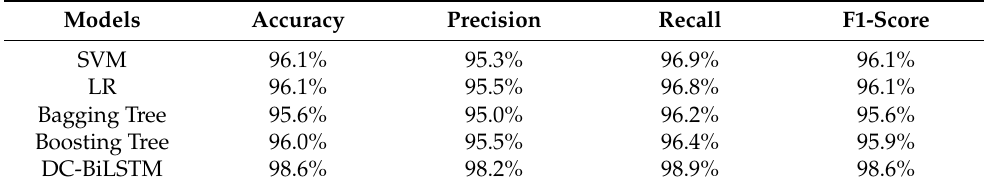
Table 4. Comparative analysis of the performance of multiple classifiers in distinguishing between benign and malignant tissue. The performance metrics are for the internal test dataset.